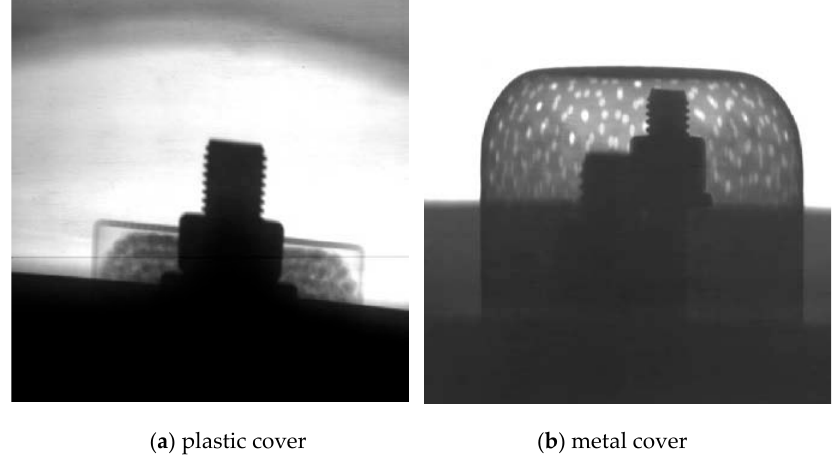
Figure 12. The images of adsorbent cover with different materials.